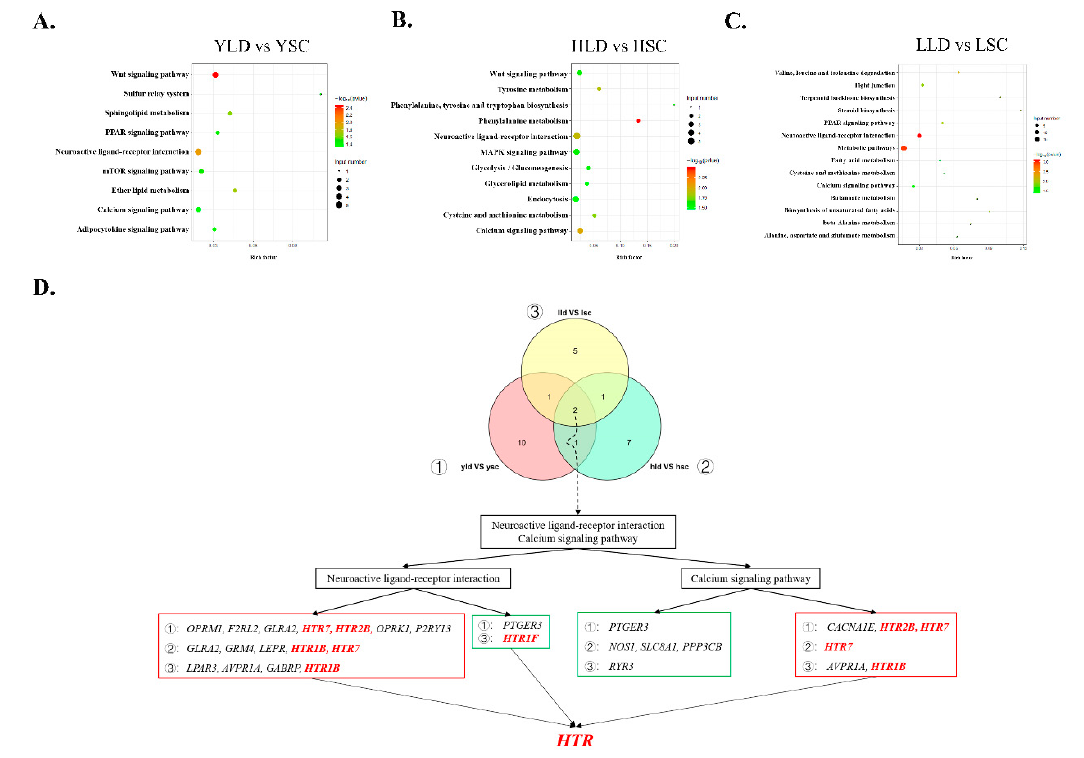
Figure 3. Kyoto Encyclopedia of Genes and Genomes (KEGG) pathways enriched in the DEGs found between the breeds. The KEGG pathways of the DEGs between YLD vs. YSC ( A ), HLD vs. HSC ( B ), and LLD vs. LSC ( C ). ( D ) The neuroactive ligand–receptor interaction pathway and calcium signaling pathway overlapped in the three groups. The red box represents significantly upregulated DEGs, and the green box represents significantly downregulated DEGs. All the DEGs associated with HTR are shown in red.